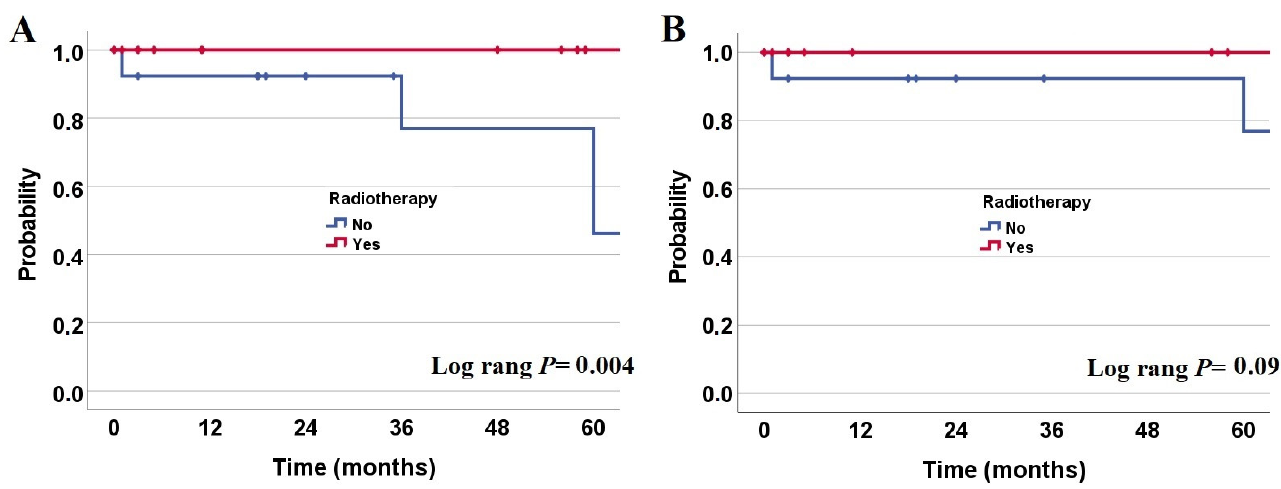
Figure 1. Kaplan–Meier estimate of progression-free survival ( A ) and overall survival ( B ) in central neurocytoma patients according to radiotherapy administration (N = 33).